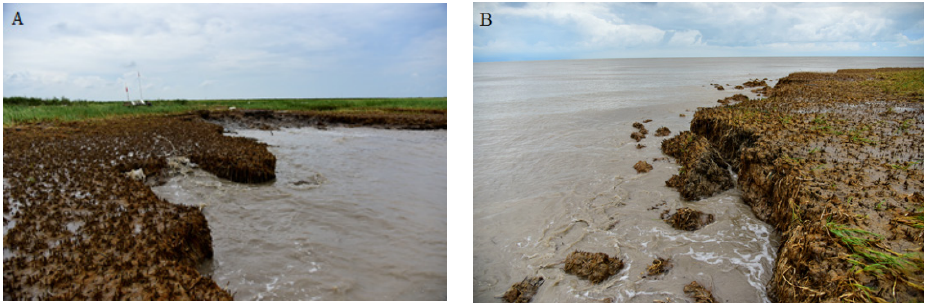
Figure 5. The jagged eroding salt marsh boundary. Photo ( A ): vertical scarps; photo ( B ): mud blocks from toppling failure. Both photos were taken on 15 September 2020. The location is shown in Figure 3 (camera B).